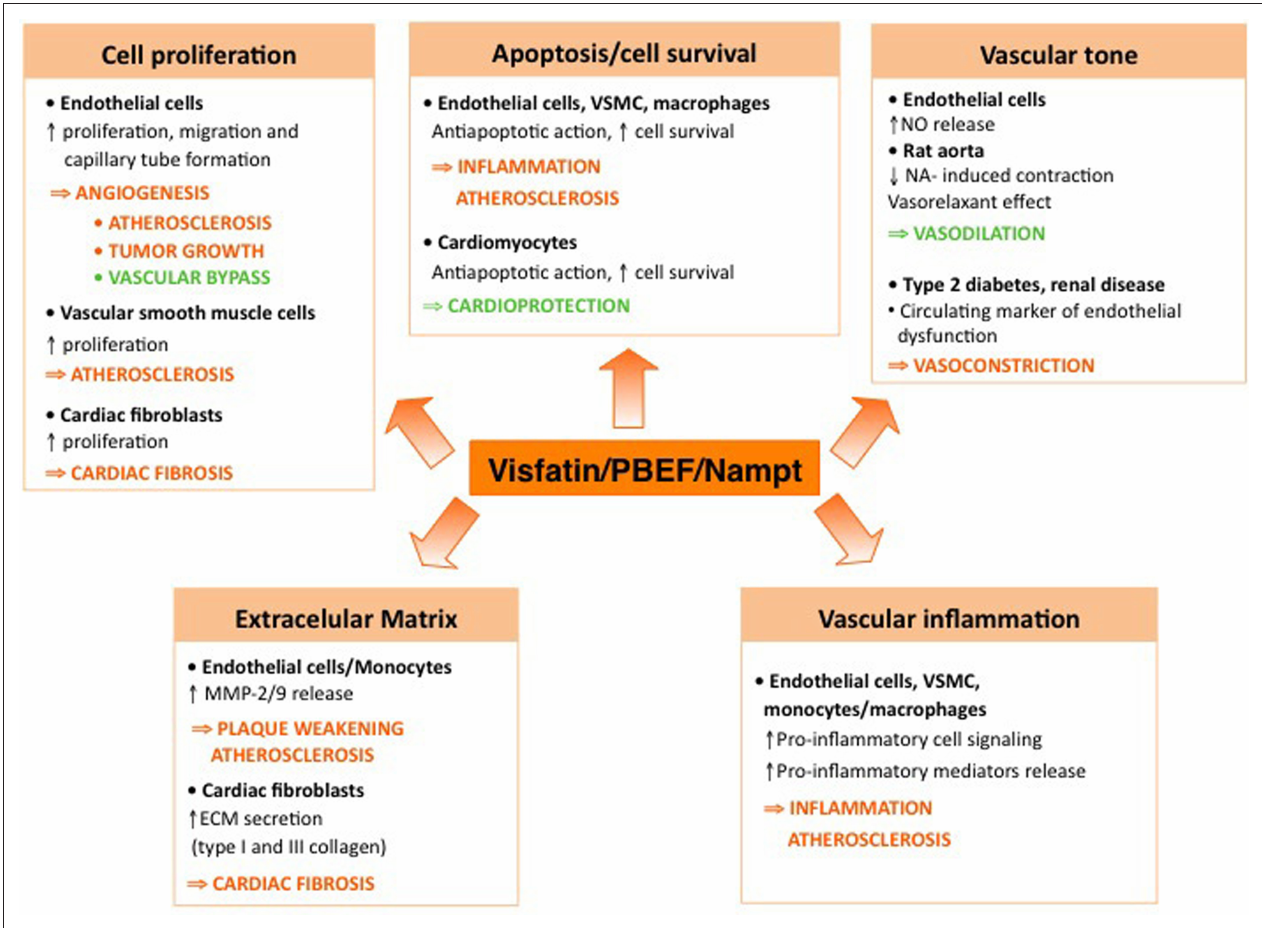
arrows, detrimental actions; green arrows, beneficial actions). Some of the actions of visfatin remain to date highly contradictory, such as its role in the regulation of the vascular